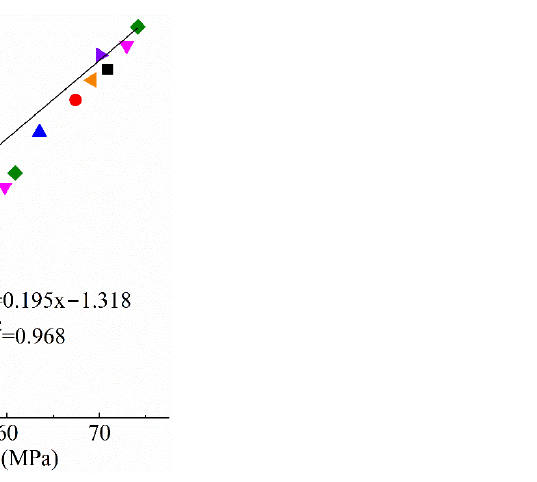
Figure 5. The correlation between abrasion resistance and compressive strength of hydraulic